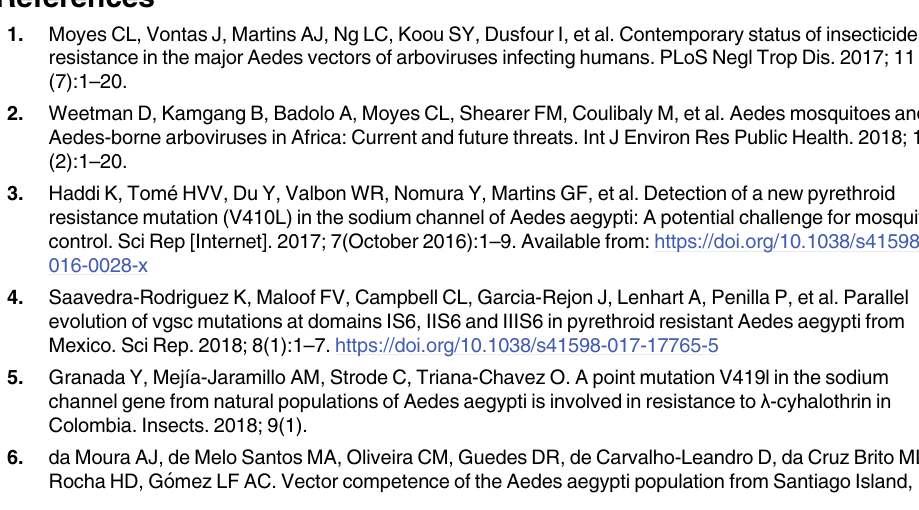
S1 Table. Mortality rates of Aedes aegypti from Angola and Cape Verde islands exposed to insecticides at diagnostic